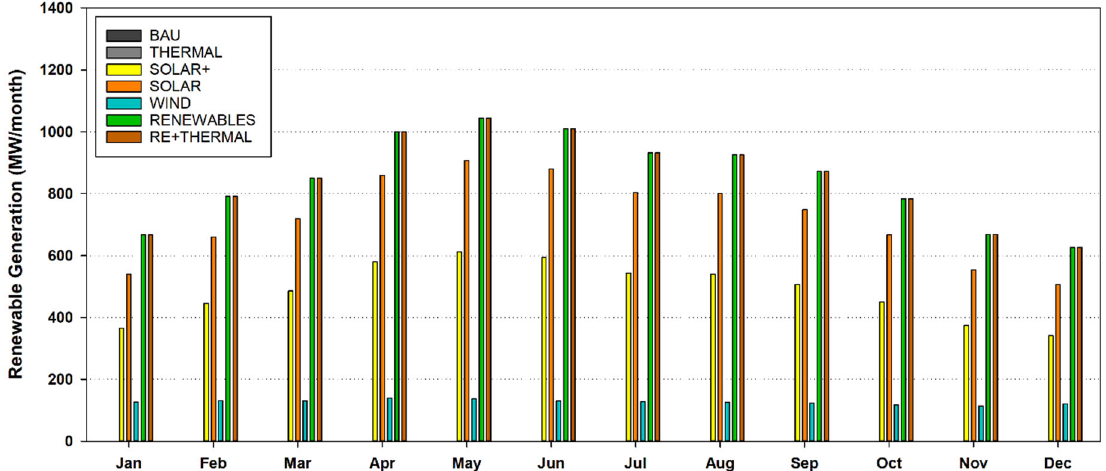
Figure 15. Monthly renewable power generation of the system for forecast year.